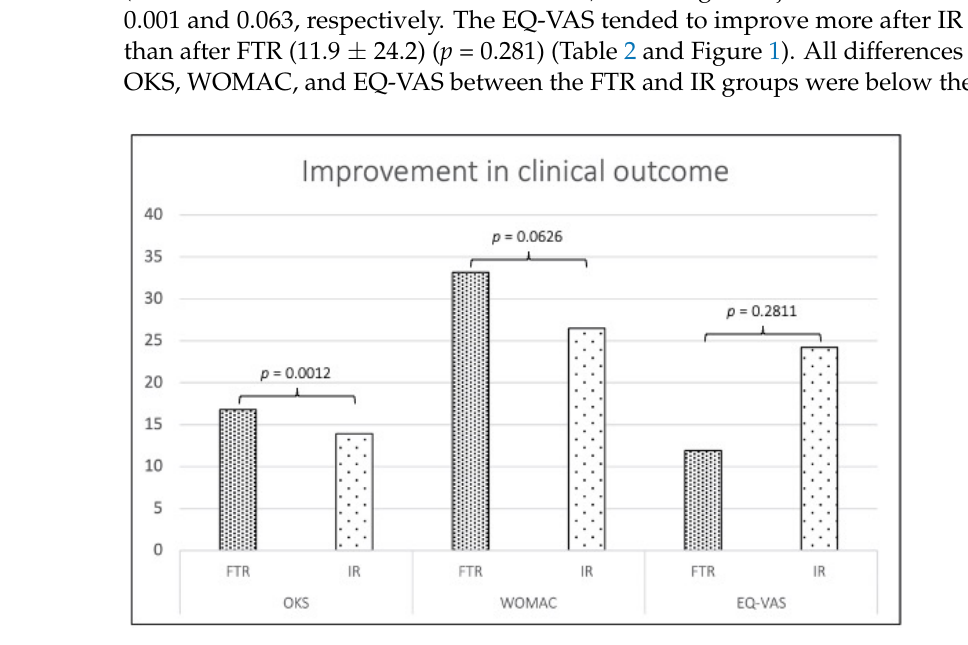
Figure 1. Improvement in clinical outcome. OKS, Oxford Knee Score; WOMAC, Western Ontario and McMaster Universities Arthritis Index; EQ-VAS, EuroQol visual analogue scale; FTR, fast-track rehabilitation; IR, inhouse rehabiliation; p -values for clinical improvements are from multivariable models; improvements in WOMAC are shown in the positive direction for comparison.